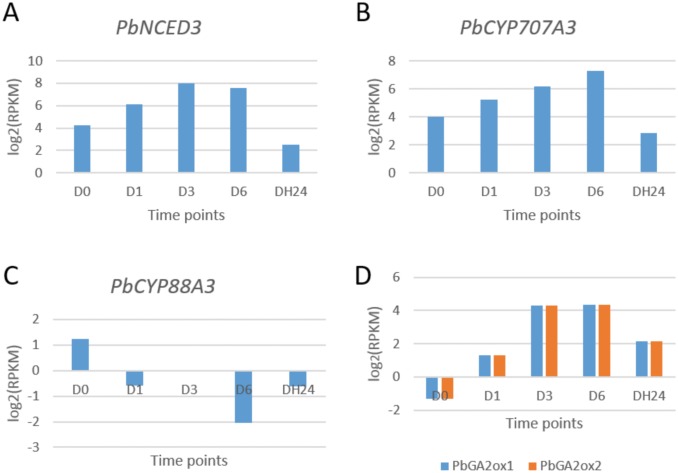
Expression patterns of genes involved in ABA and GA metabolism.